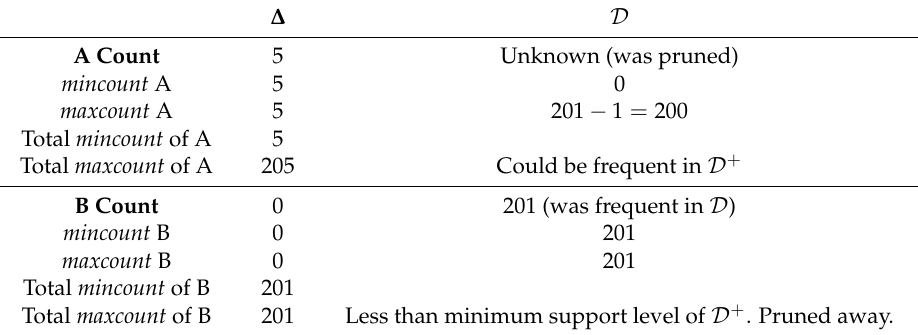
Table 5. Early pruning example values for incremental D and ∆